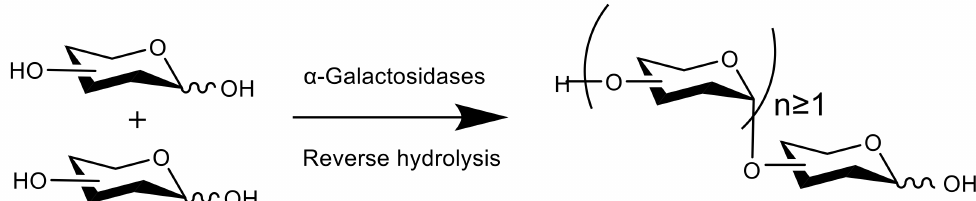
Figure A1. α -Galactosidases-catalyzed oligosaccharide synthesis by reverse hydrolysis. The monosaccharide galactose is Molecules 2021 , 26 , x FOR PEER REVIEW used as glycosyl donor. The monosaccharide and newly produced oligosaccharides can be used as glycosyl acceptor.